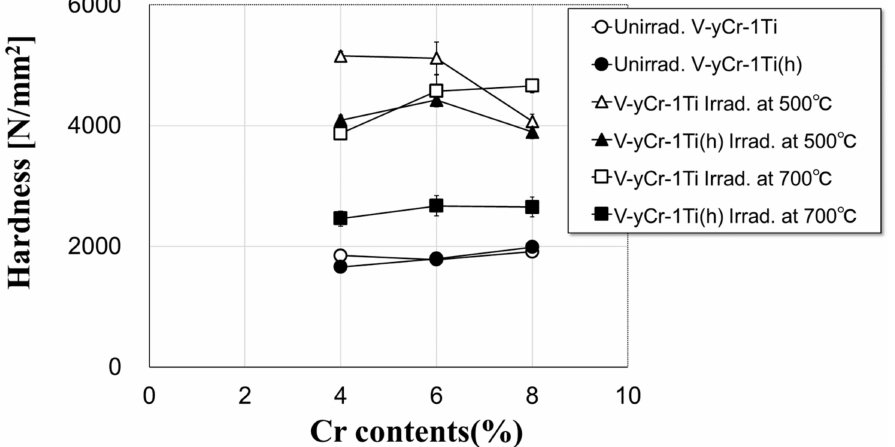
Figure 4. Cr content dependence of nano-indentation hardening for unirradiated V–yCr–1Ti alloys and He-irradiated V–yCr–1Ti alloys at 500 ◦ C and 700 ◦